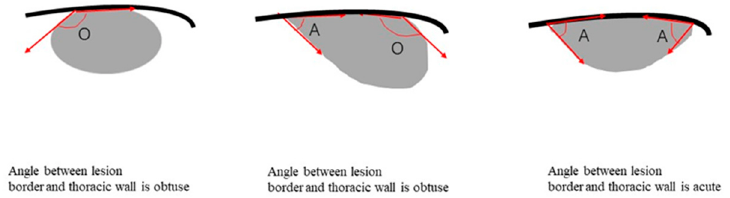
Figure 2. Illustration of the parameter of angle between lesion border and thoracic wall for subpleural pulmonary lesions. Black line represents the thoracic wall. Gray region represents the subpleural lesion. We drew an angle at the intersection of the edge of the lesion and the chest wall. As shown